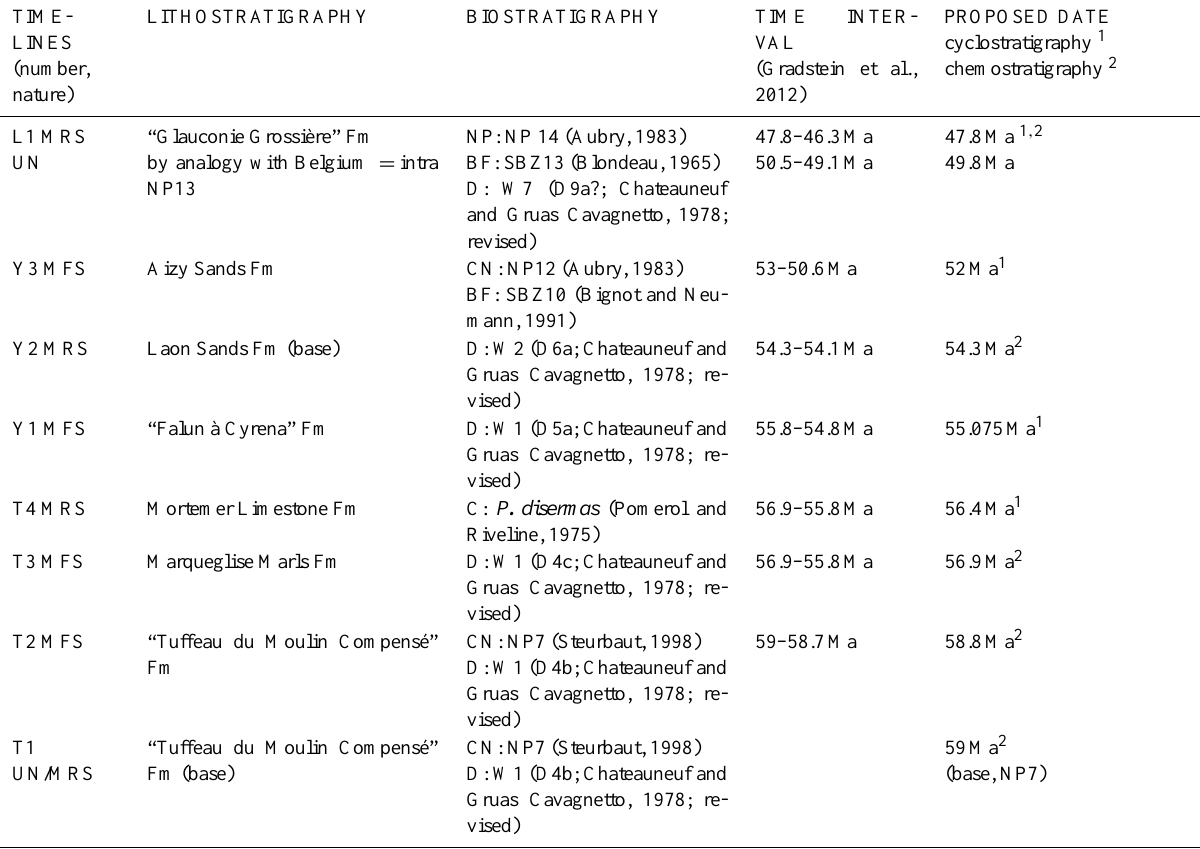
Table 2. Age model for the bounding cycles of the stratigraphic surfaces (MFS, MRS, and Unconformities). TIME-